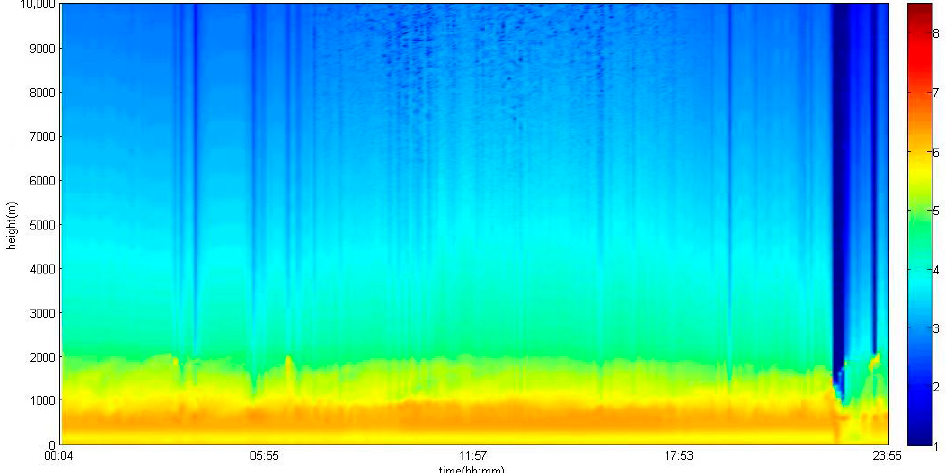
Figure 5. Pseudo-color map for aerosol extinction coefficient (10 − 4 m − 1 ) in Sansha on 11 February 2021.